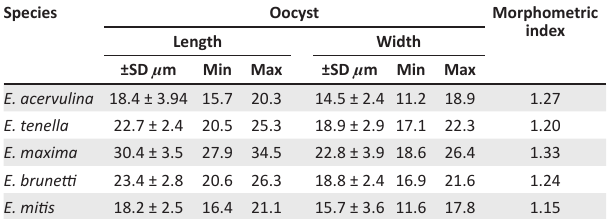
TABLE 3: Biometric characteristics of oocysts of different species of the genus Eimeria isolated in Bejaia province. Species Oocyst